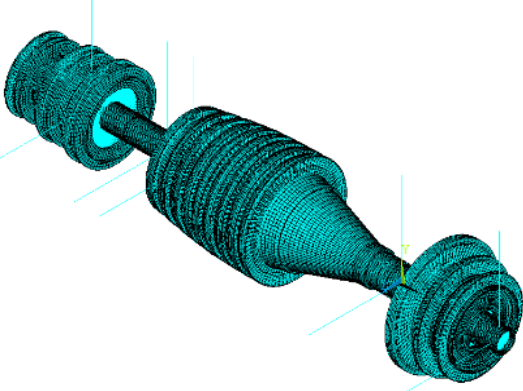
Figure 2. Finite element model of dual-rotor system.